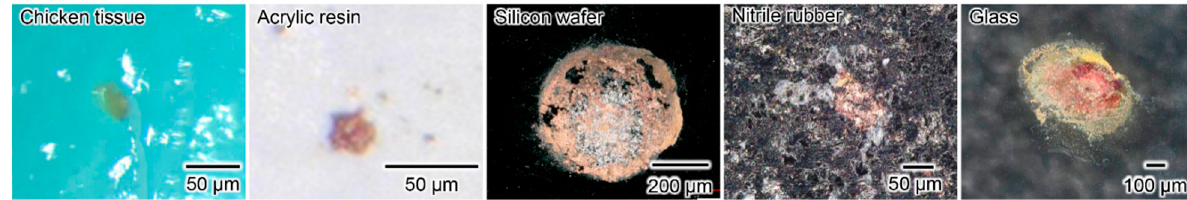
Figure 6. Copper deposition on various material surfaces (chicken tissue, acrylic resin, silicon wafer, nitrile rubber, glass). A copper sulfate solution was used as the solution, and Type A was used as the device.